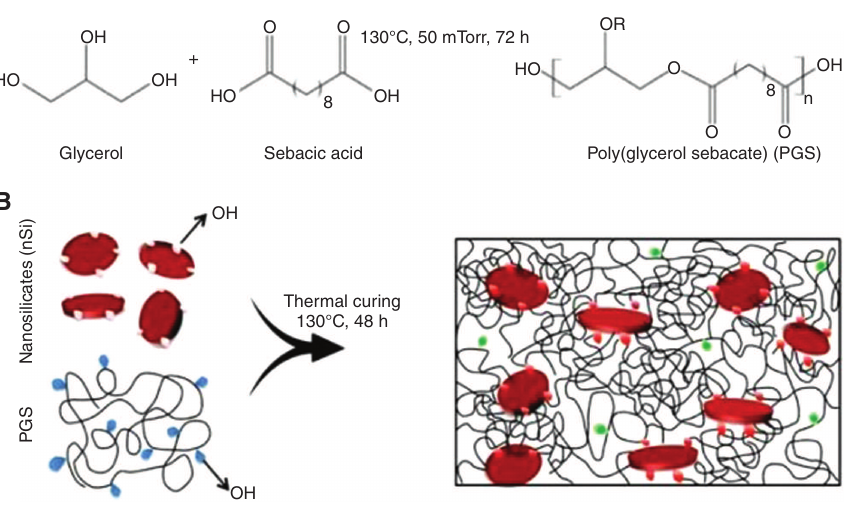
Figure 15: (A) Chemical structure of PGS. (B) Interactions between PGS chains and nanosilicates. Reprinted from Ref. [40], Copyright (2015), with permission from